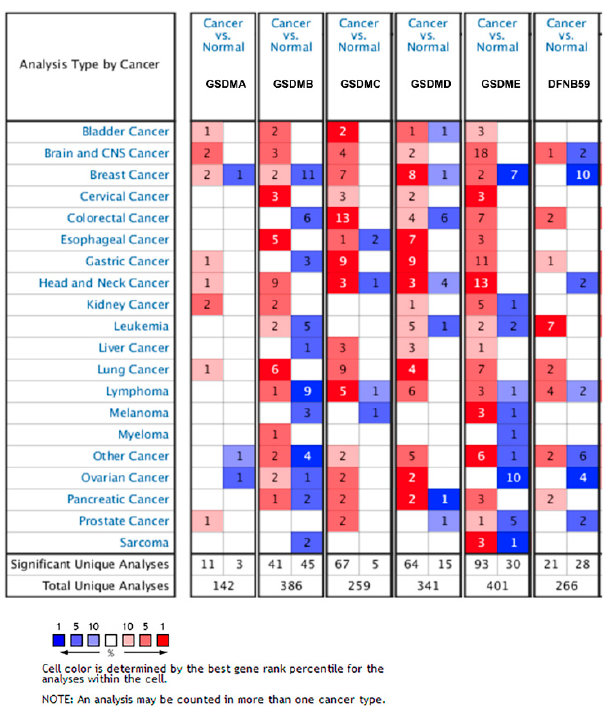
Figure 1. Transcriptional level of GSDMs in glioma. The mRNA and protein alteration of GSDMs in different types of cancers in Oncomine.